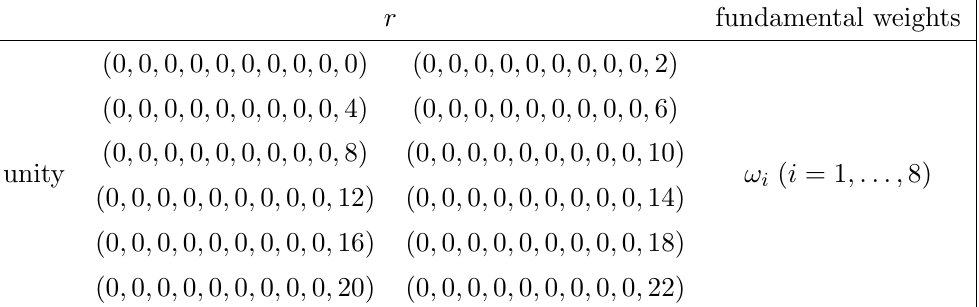
Table 11 . The r -(cid:12)elds of the n = 12 model and the fundamental weights of e 8 which induce the same embedding (cid:30) : Q _ , ! P . All the r -(cid:12)elds and all the fundamental weights induce the same embedding as Q _ = P for e 8